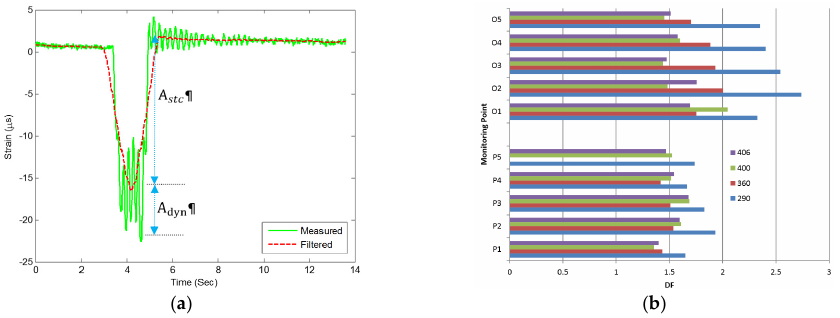
Figure 10. Measured static strain and dynamic factor of the strain. ( a ) measured and filtered static strain; ( b ) dynamic factor of the monitoring points.